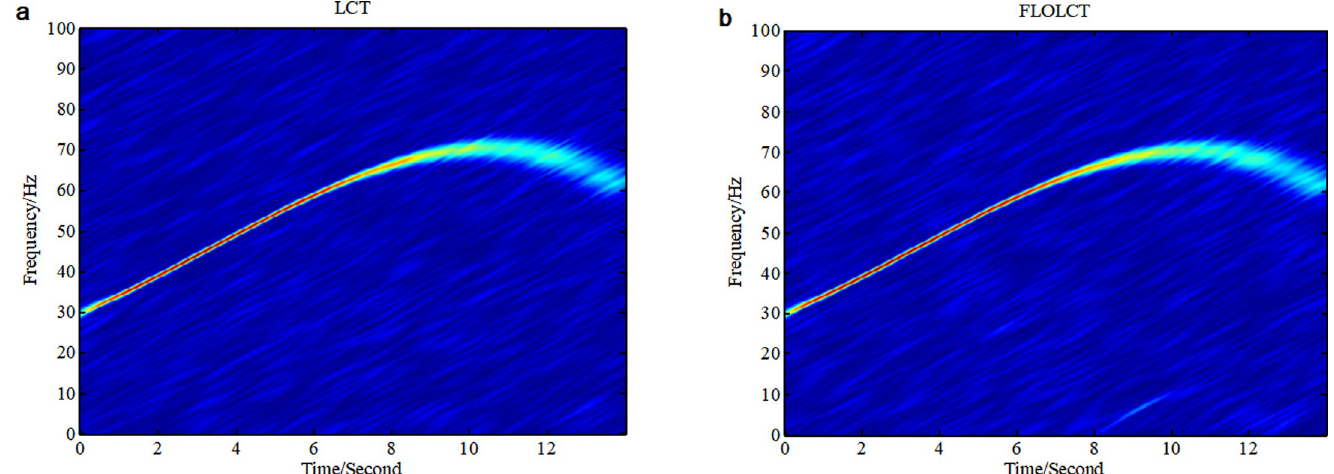
Fig 4. Time-frequency representations of the signal x ( τ ) in Gaussian noise environment ( c = 6, SNR = 6 dB ). (a. LCT time-frequency representation of the signal x ( τ ); b. FLOLCT time-frequency representation of the signal x ( τ )).